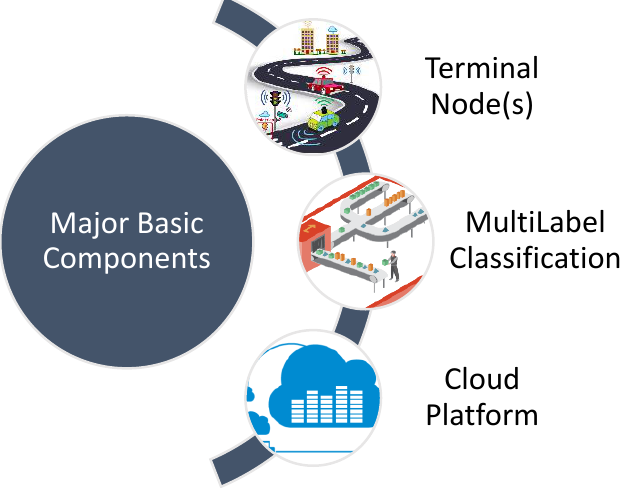
Figure 6. The proposed system components.